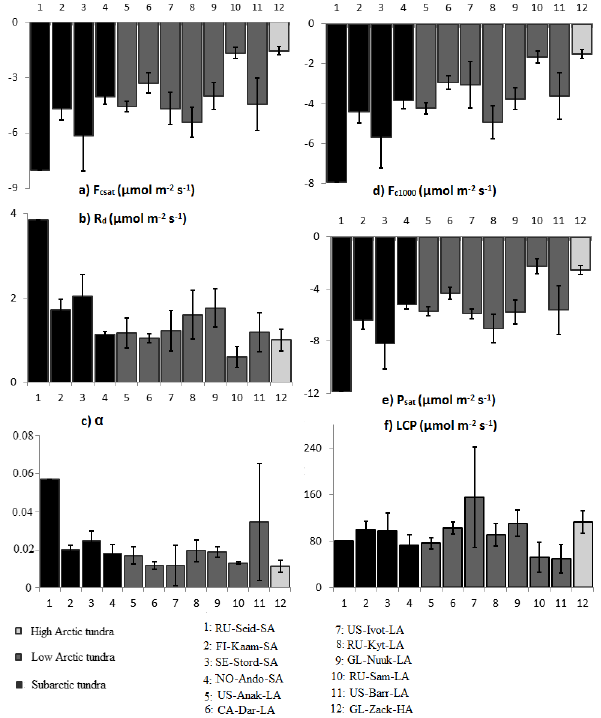
Figure 4. Light response curves across the Arctic tundra, (a) High Arctic sites, (b) Low Arctic sites, (c) Subarctic sites; classification according to Arctic floristic boundaries (AMAP,